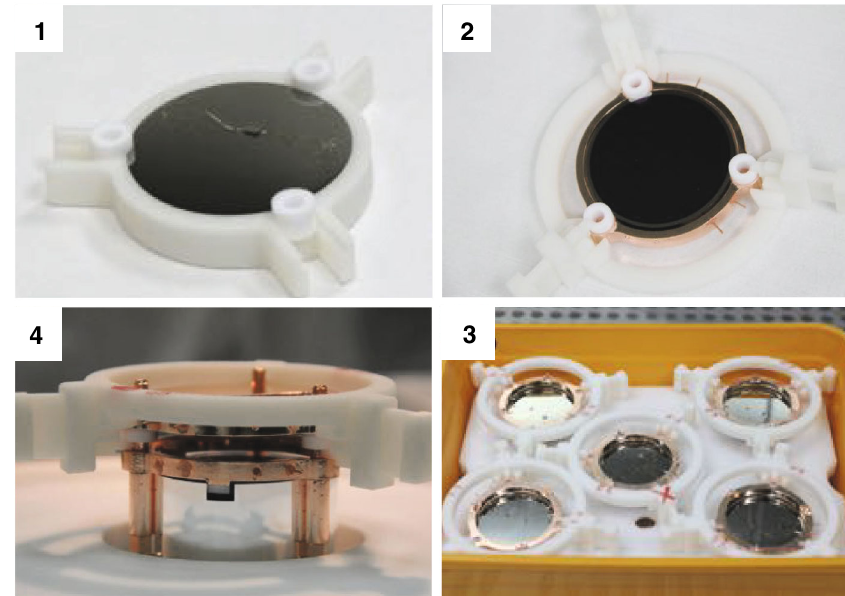
Fig. 12 Light detectors assembly: (1) Positioning of the Ge wafer with the PTFE O-shape holders on the mounting template. (2) Positioning of the copper holder and connection of the Ge-NTD gold wires for the detector read-out. (3) Storage of the assembled light detectors in a vacuum box. (4) Fit and tighten of the handling tool and removal from the mounting